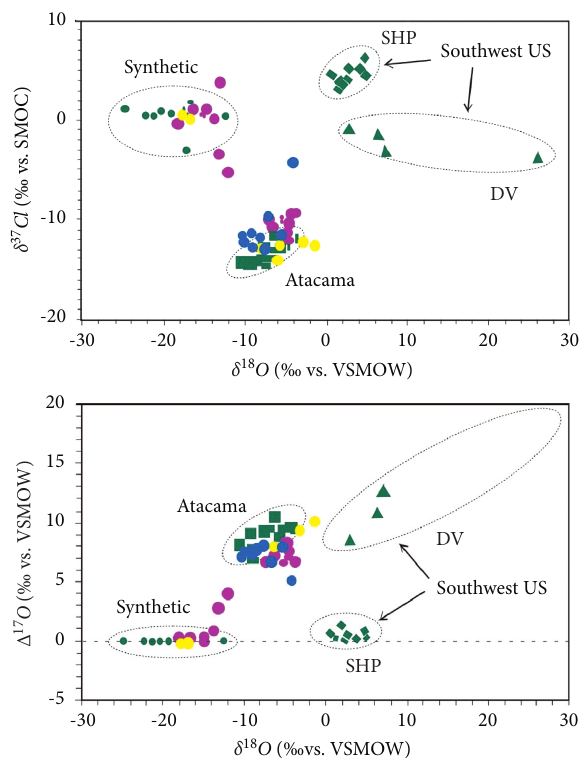
Figure 4: δ 37 Cl (‰) versus δ 18 O (‰) values and Δ 17 O (‰) versus δ 18 O (‰) values show stable isotope data for ClO 4 − in groundwater samples from the Chino Basin, California (blue symbols) [56], Long Island, New York (yellow symbols) [57], and southeastern San Bernardino Basin, California (red symbols) [58] in comparison to the principal known source types in the region, which is shown in Figure